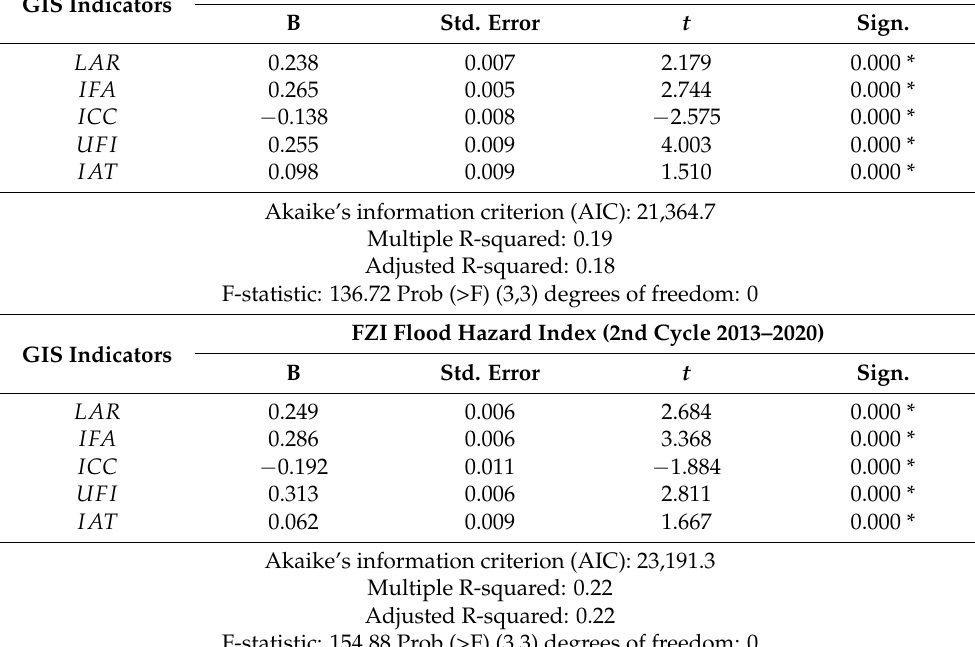
Table 4. Results of the evaluation of the existing statistical correlation between the indicators for the analysis of urban growth patterns in the city of Murcia and the FZI flood zone indicator. GIS